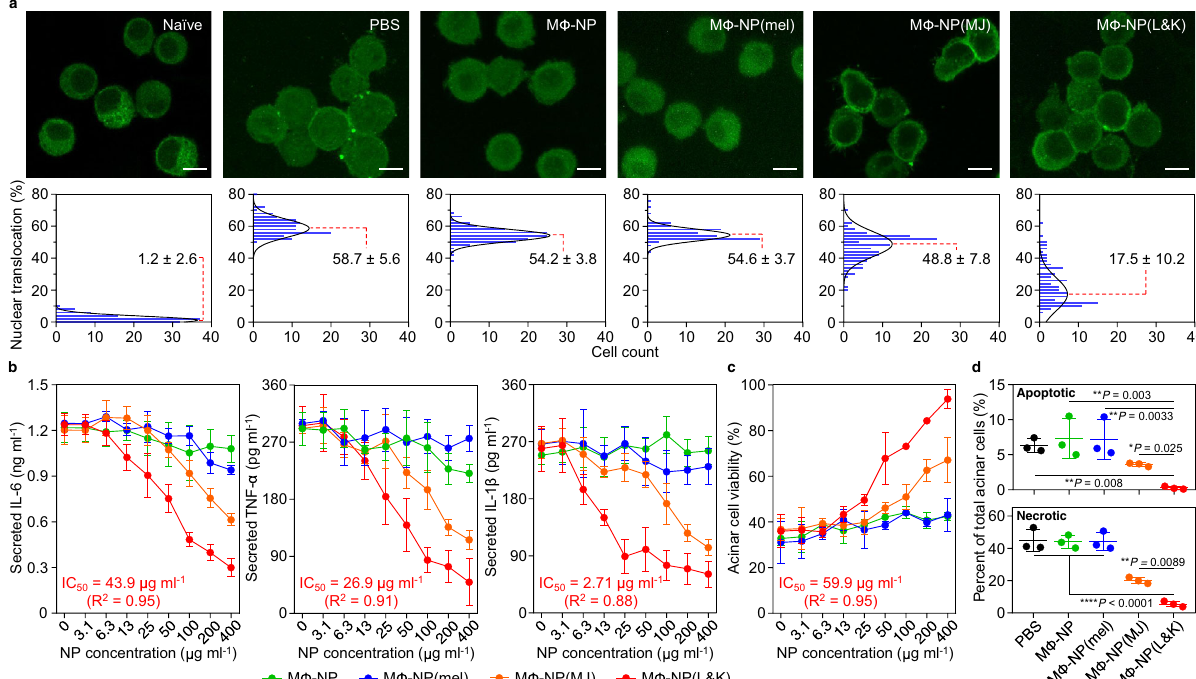
Fig. 3 Suppression of PLA2-induced in fl ammatory response in vitro. a Effects of M Φ -NP(L&K) and control formulations on NF- κ B nuclear translocation of PLA2-stimulated macrophages. Representative fl uorescence images (top row, scale bar, 10 μ m) and quanti fi cation of nuclear translocation (bottom row) based on corresponding fl uorescence images. b Effects of M Φ -NP(L&K) and control formulations on IL-6, TNF- α , and IL-1 β production from PLA2- stimulated macrophages. c Effects of M Φ -NP(L&K) and control formulations on cell viability of PLA2-stimulated pancreatic acinar cells. d Effects of M Φ - NP(L&K) and control formulations on apoptosis and necrosis analyzed by fl ow cytometry using annexin V/PI double staining. Results were analyzed by using one-way ANOVA with Dunnett ’ s post hoc analysis in Graphpad Prism. Data presented as mean ± s.d. In all datasets, n = 4 independent experiments using the same batch of M Φ -NP(L&K). IC 50 and EC 50 values were derived from the variable slope model using Graphpad Prism 8. Source data are